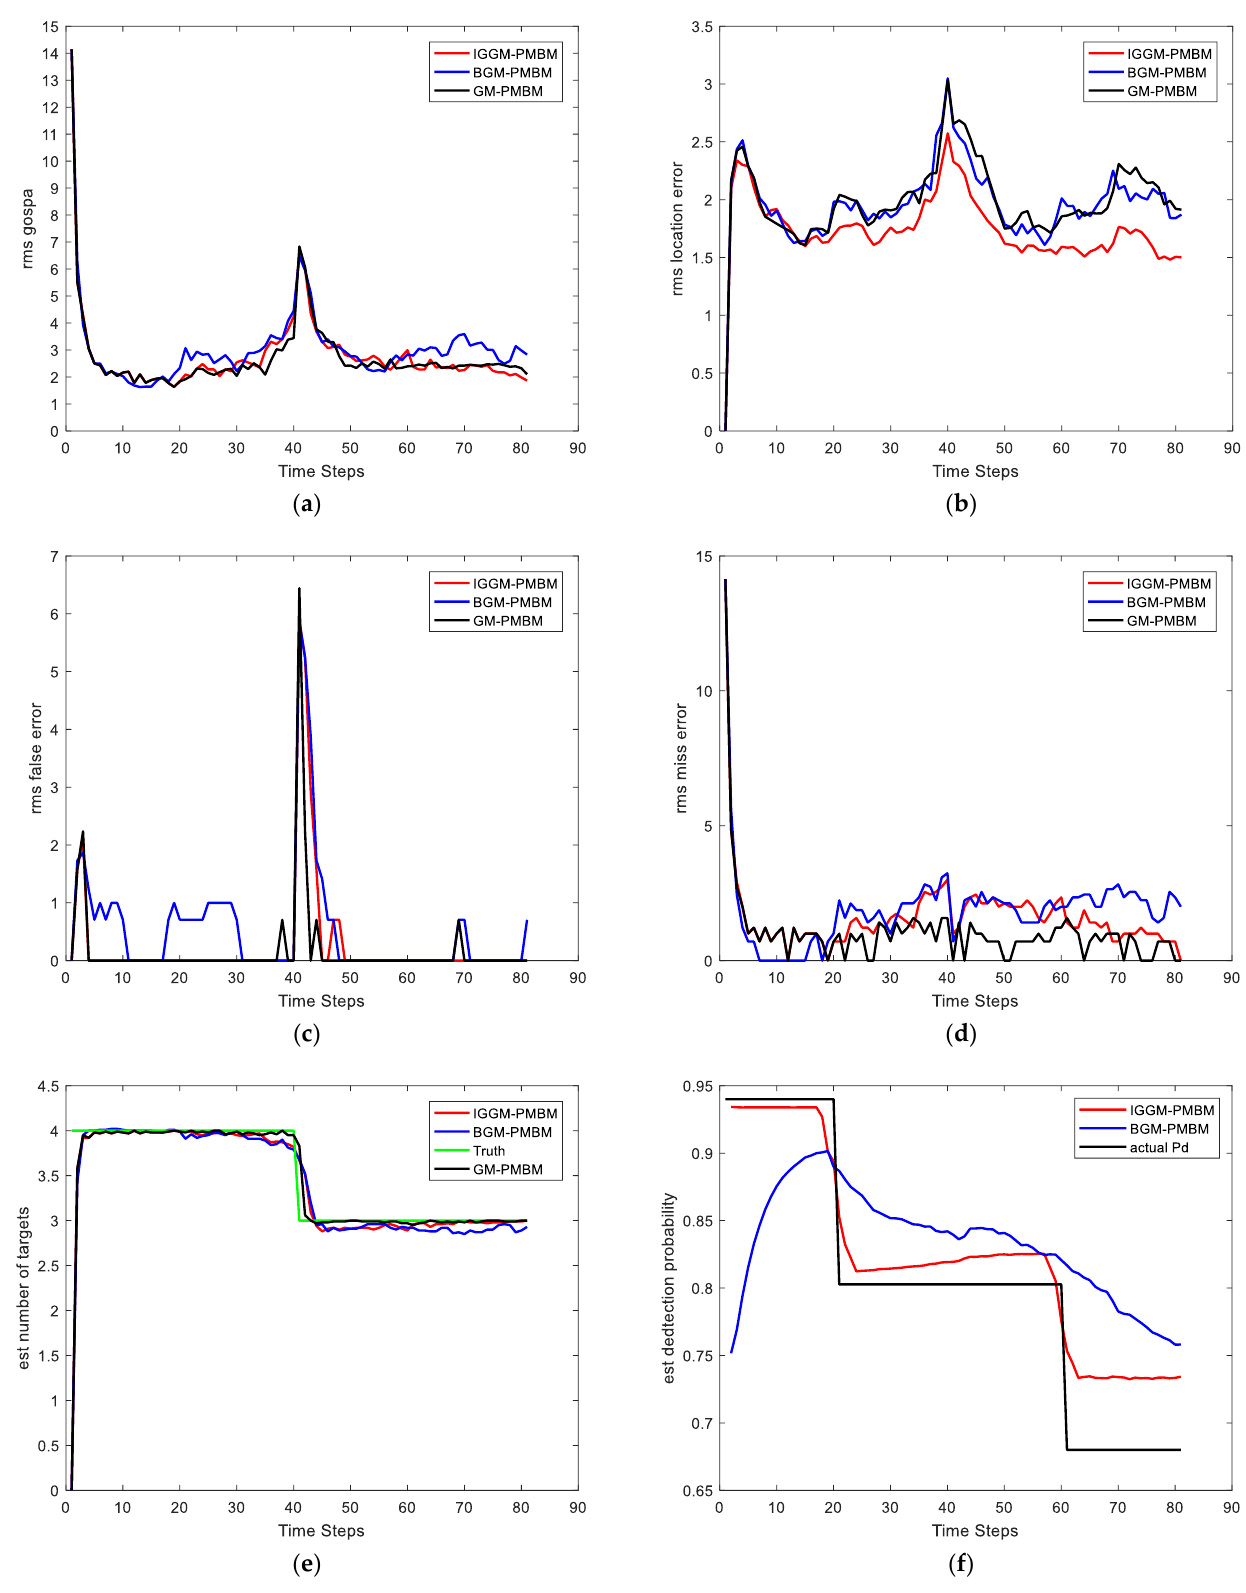
Figure 8. Comparisons of ( a ) GOSPA error, ( b ) Location error, ( c ) False error, ( d ) Miss error, ( e ) the number of targets and ( f ) the estimated 𝑃 𝐷 .